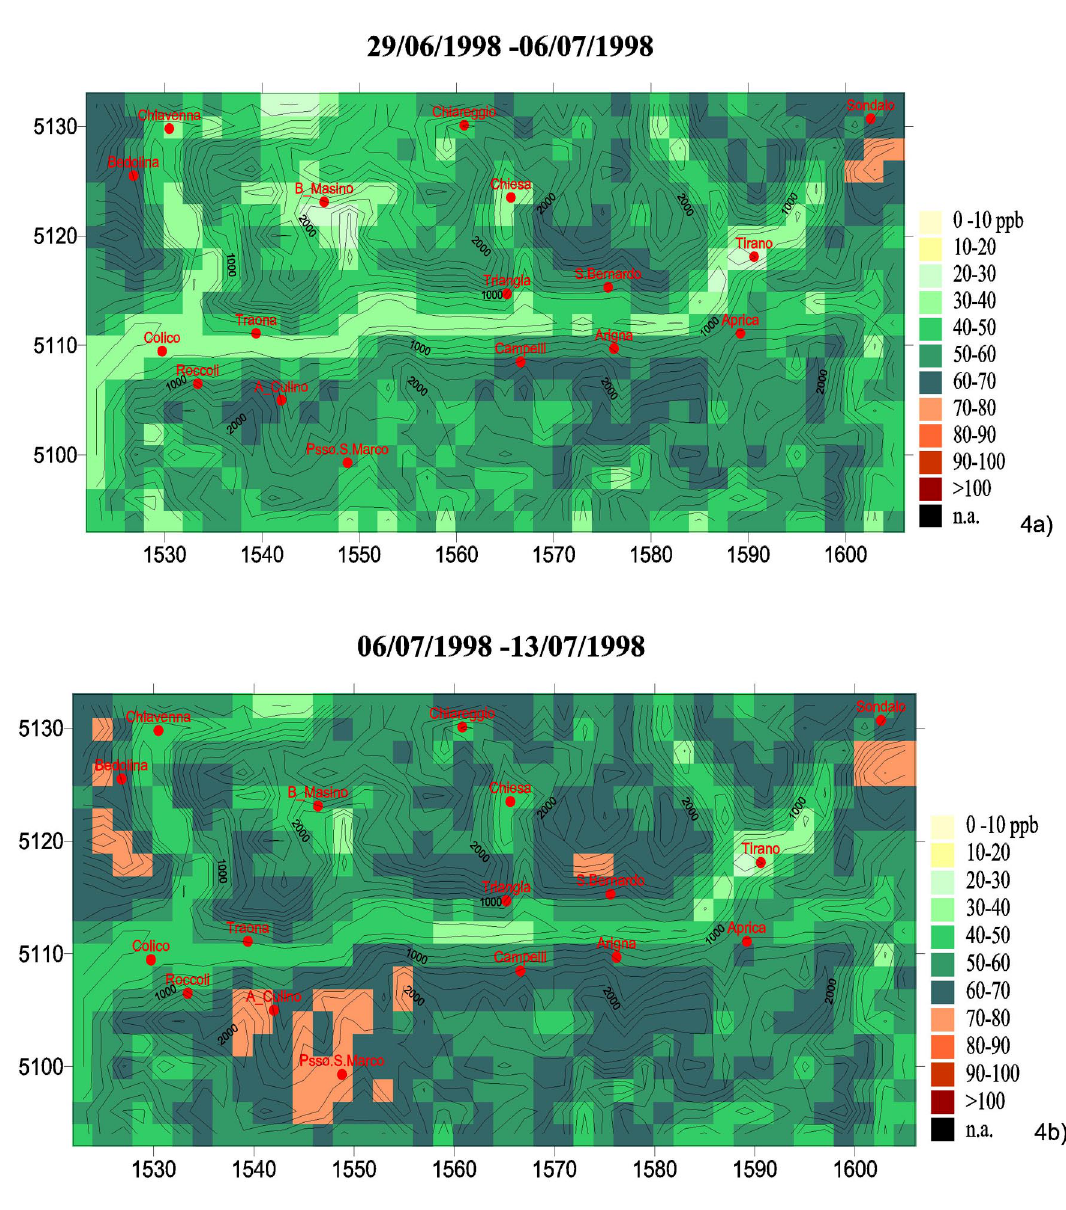
FIGURE 4. Ozone weekly concentrations (interpolation procedure described in the text): (a) June 29 to July 6; (b) July 6 to 13; (c) July 13 to 20; (d) July 20 to 27. (Figs. 4c and 4d on following